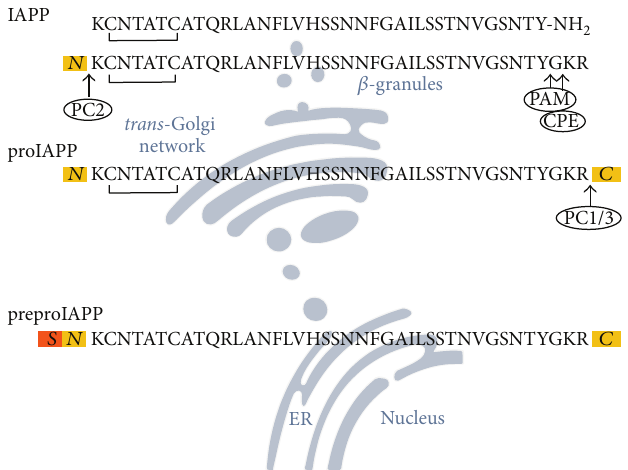
Figure 1: Posttranslational modification of hIAPP through the secretory pathway in islet 𝛽 -cells. Upon expression of the preproIAPP, a disulfide bond is formed at the ER and the N-terminal signal peptide ( 𝑆 : MGILKLQVFLIVLSVALNHLKA) is cleaved after transport to the trans -Golginetwork.ThecleavageoftheC-terminusfragment( 𝐶 :NAVEVLKREPLNYLPL)fromproIAPPiscatalyzedbyPC1/3.PC2removes the N-terminal fragment ( 𝑁 : TPIESHQVEKR) of proIAPP within the secretory vesicles. The remaining basic residues at the C-terminus are removed by the action of CPE. The final step of removal of Gly38 and amidation of IAPP at the C-terminus is realized by the PAM complex.